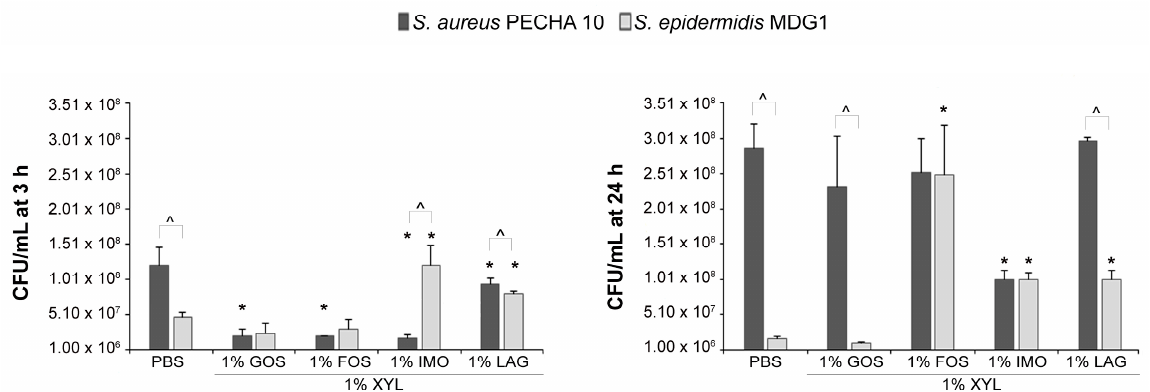
Figure 4. CFU/mL of S. aureus PECHA 10 and S. epidermidis MDG1 in co-culture assay after 3 and 24 h of prebiotics treatment. * statistically significant with respect to the corresponding strain in PBS. ^ statistically significant between the two tested strains. For abbreviations, see materials and methods.